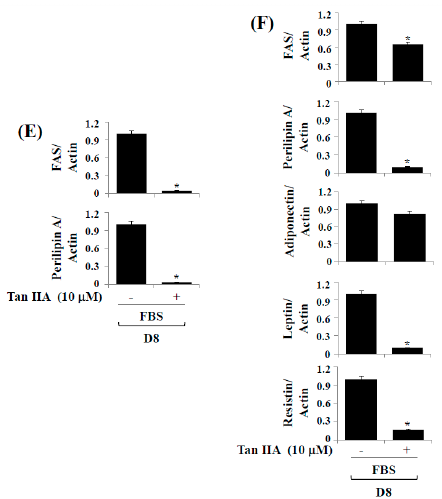
Figure 4. Effects of tanshinone IIA on protein and/or mRNA expression levels of FAS, perilipin A, leptin, and resistin during 3T3-L1 preadipocyte differentiation. ( A , B ) 3T3-L1 preadipocytes were induced to differentiate with induction medium containing MDI, insulin, and FBS in the presence or absence of tanshinone IIA, and harvested at D2, D5, and D8, respectively. Total cellular protein and mRNA at the indicated time point were extracted and analyzed by Western blot ( A ) and RT-PCR ( B ) analysis, respectively; ( C , D ) Western blot ( C ) and RT-PCR ( D ) analysis in triplicate experiments on D8, respectively; ( E , F ) The densitometry data of ( C , D ), respectively. * p < 0.05 compared to the value of tanshinone IIA free control at the indicated day.